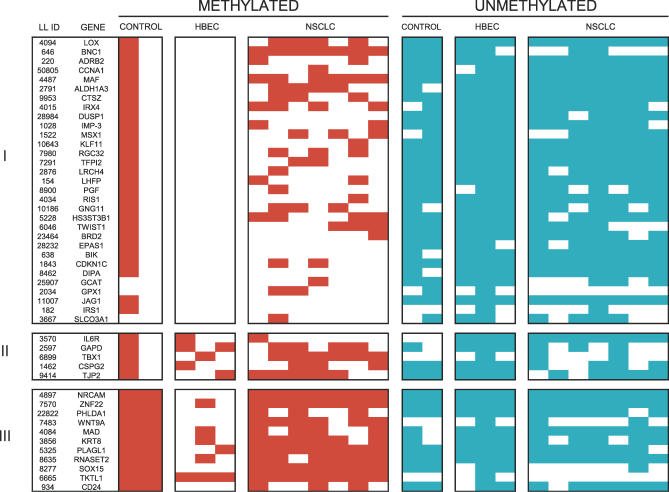
Summary of Methylation-Specific PCR in HBEC and NSCLC Cell LinesFrom the left, Locus Link ID (LL ID), gene symbol (GENE), in vitro methylated (SssI) DNA mixed with lymphocyte DNA, normal PBC DNA, HBEC lines, NSCLC cell lines, as indicated. Red fill indicates positive methylated product; blue indicates positive unmethylated product. Data are grouped as follows: group I, no methylation in either HBECs or PBC DNA; group II, methylation in HBECs but not PBCs; group III, methylation in PBCs. Data are ordered by the frequency of methylation in primary lung tumors (Figure 6).